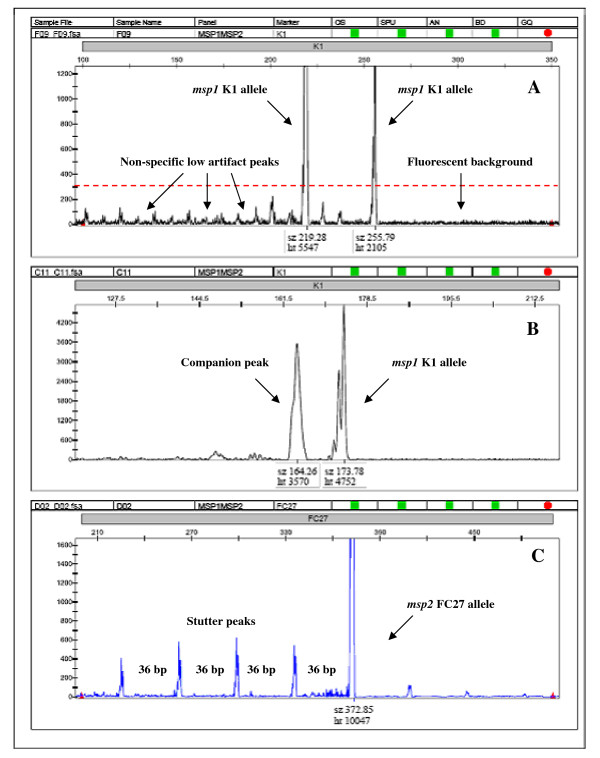
Screenshot of electropherogram (GeneMapper® software) displaying different artifacts: A) fluorescent background (right) and non-specific low background (left) in a field sample with 2 msp1 K1 alleles. The red striped line indicates the cut-off at 300 relative fluorescent units (rfu). B) Companion peak, to the left of a true peak of an msp1 K1 allele from a single laboratory line. C) Stutter peaks in a sample with the K1 laboratory line amplified with msp2 FC27 primers. The y-axis depicts the rfu while fragment size (sz) in base pair and rfu height (ht) for individual alleles is depicted on the x-axis. The rfu scale on the y-axis has been adjusted to focus on the artifacts.